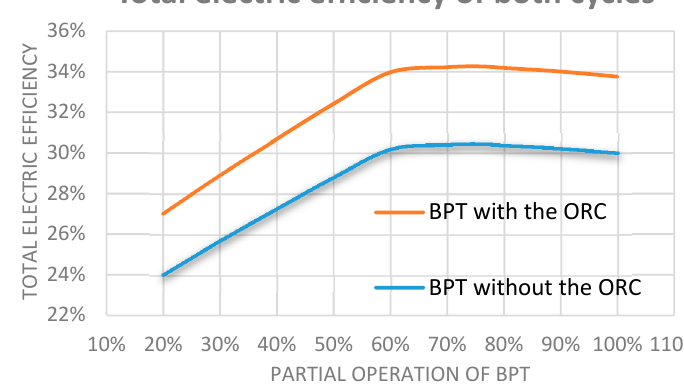
Figure 15. Sensitivity analysis of the ORC electric efficiency at the partial operation.